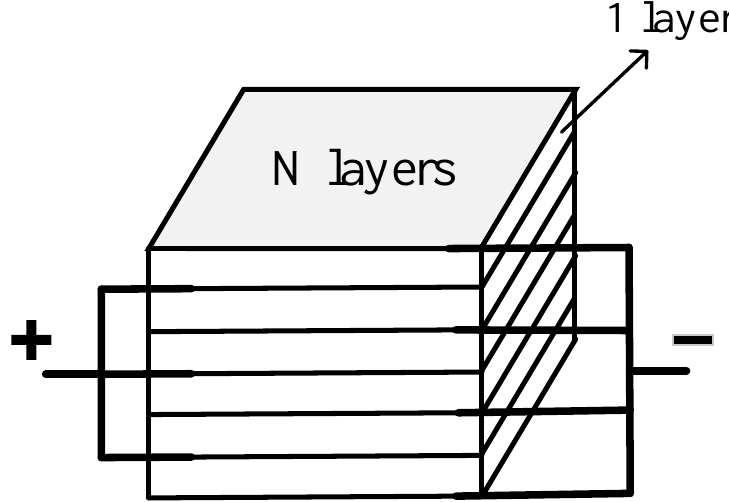
Figure 3. The electrical connection of an N -layers piezoelectric stack. The stroke ( ∆ L ) of the stack is scaled with the number of stacking layers (Equation